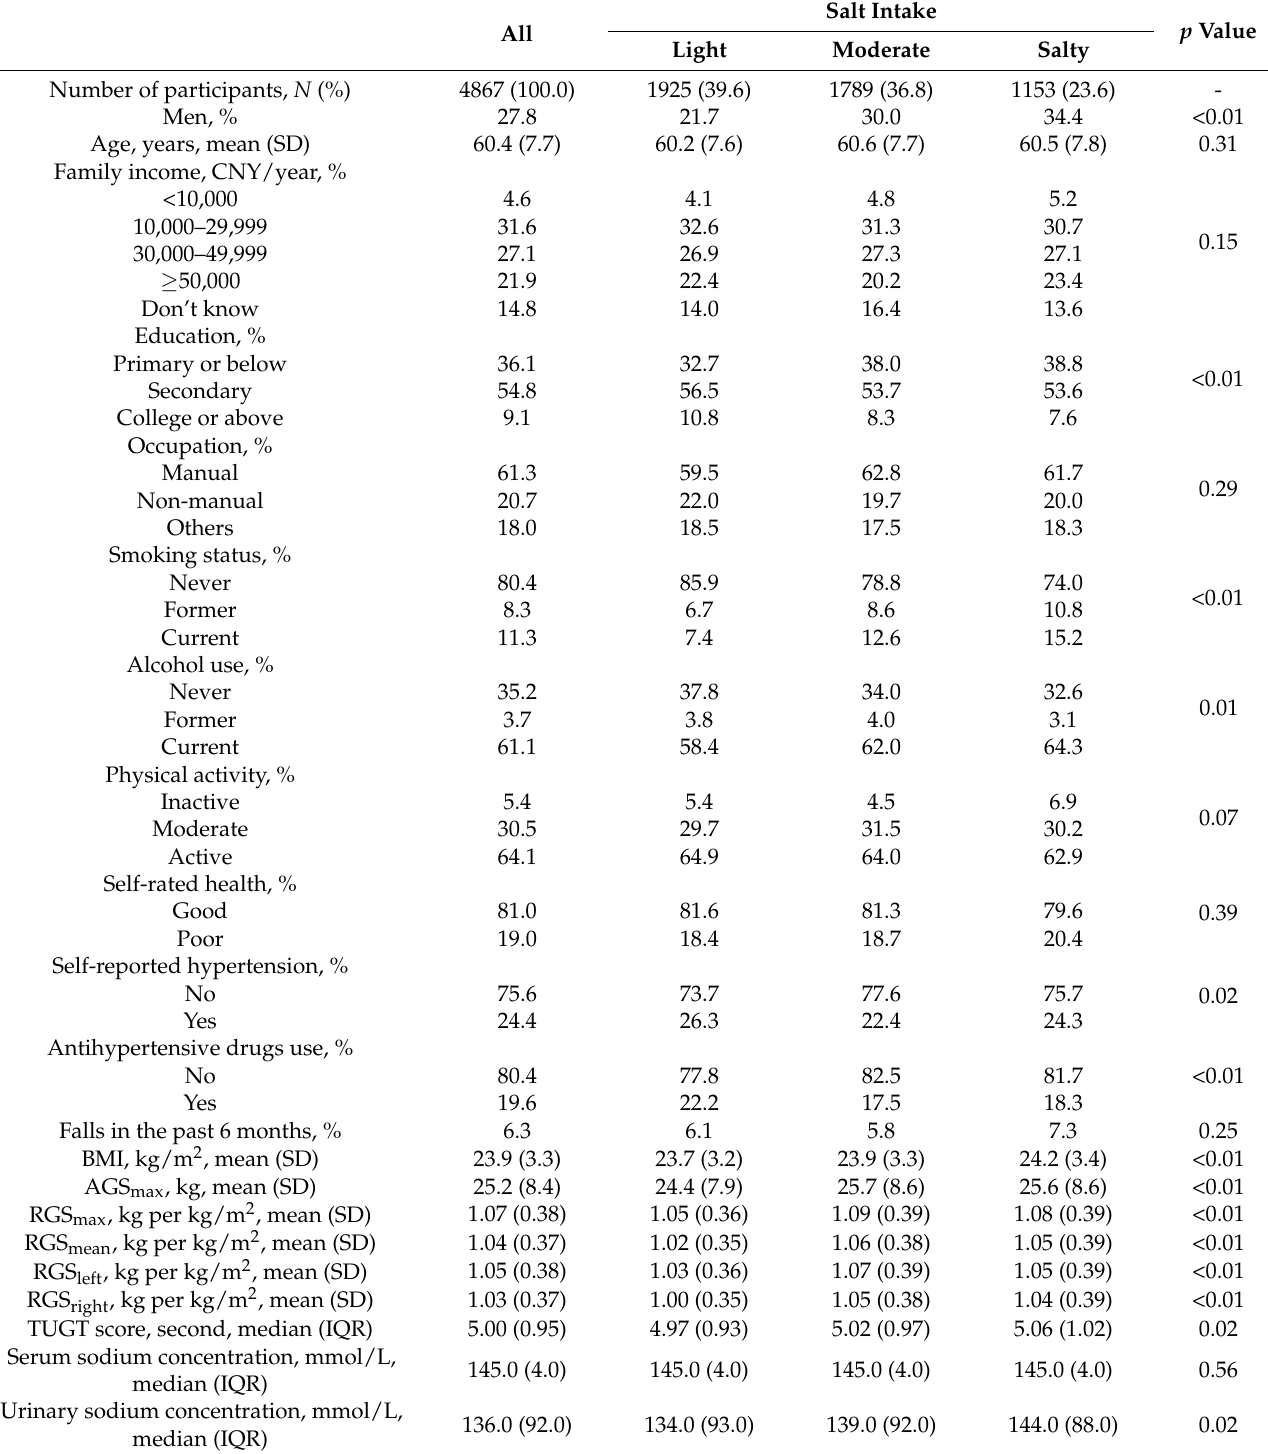
Table 1. Characteristics by salt intake on 4867 participants of the Guangzhou Biobank Cohort